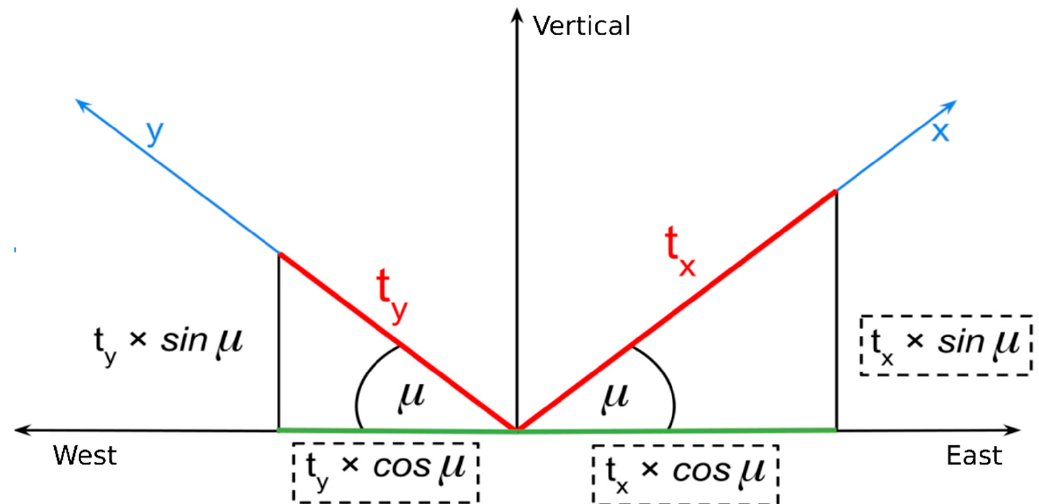
Figure 3. The vertical and east–west components of the critical displacement values determined along the x and y axes of the displacement coordinate system in the coordinate system of the 2D measurements (t x = displacement threshold defined in the displacement coordinate system in the x -axis direction, t y = displacement threshold defined in the displacement coordinate system, in the y -axis direction, x = x -axis of the displacement coordinate system, y = y -axis of the displacement coor- dinate system).